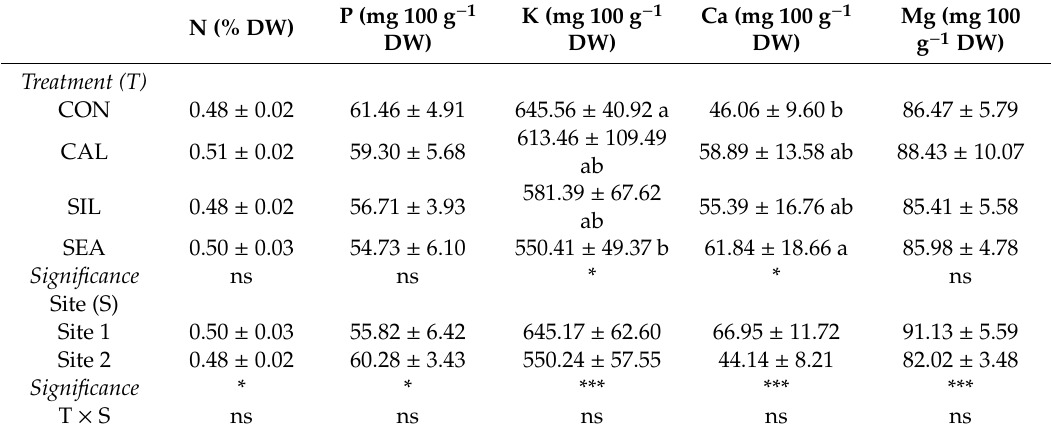
Table 5. Macronutrients content in apple skin at harvest as a ff ected by treatments and sites 1 .